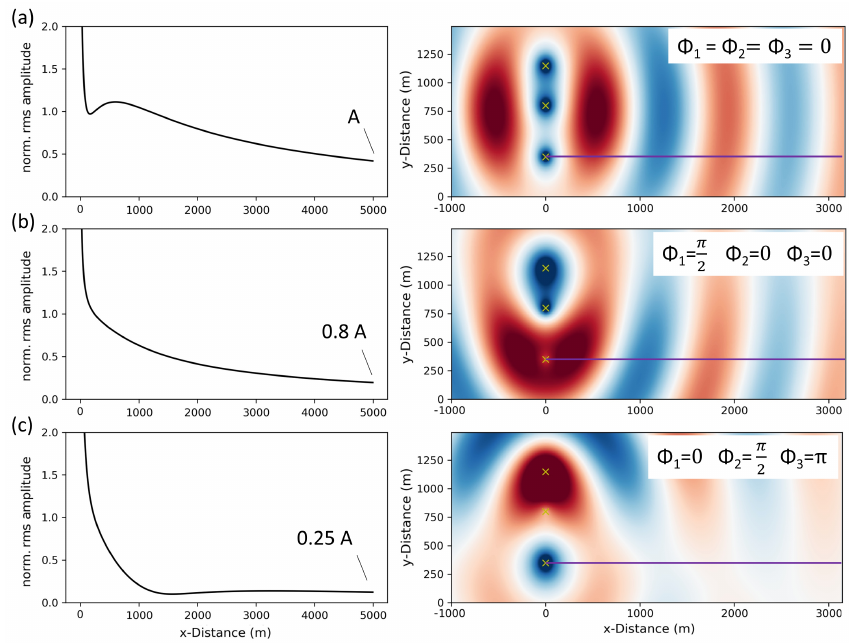
Figure 8. Calculated amplitude decay curves (in the direction of the magenta line) for three scenarios with different source signal phase compositions using (a) (cid:56) 1 = (cid:56) 2 = (cid:56) 3 = 0 (vibration in phase), (b) (cid:56) 1 = π/ 2, (cid:56) 2 = 0, (cid:56) 3 = 0, and ( c) (cid:56) 1 = 0, (cid:56) 2 = π/ 2, (cid:56) 3 = π . Index 1 represents the source point S1. All decay curves are normalized to the amplitude at x =